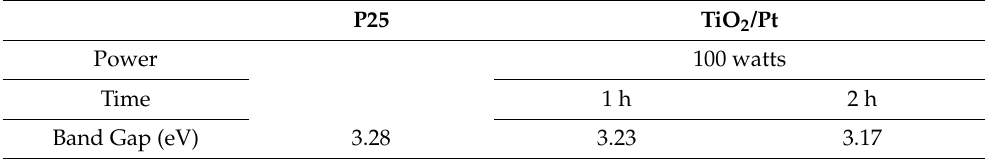
Table 2. Band gap of N-TiO 2 − x /Pt samples considering different treatment times and 100 watts of power.